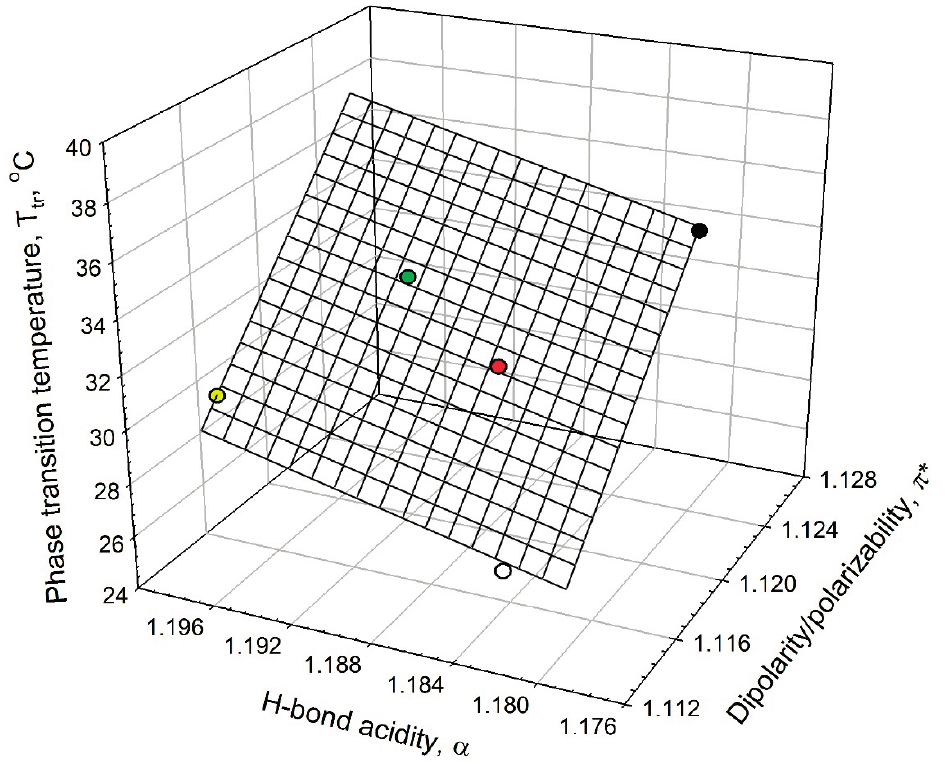
Figure 5. Interrelationship between the phase-transition temperature, T t , in ELP solutions and the solvent dipolarity/polarizability, π *, and H-bond donor acidity, α , in ELP solutions at 0.90 mM concentration in an aqueous 0.01 M sodium phosphate buffer (NaPB) of pH 7.4 (black circle) in the presence of 0.1 M·NaCl (white circle), 0.05 M Na 2 SO 4 (red circle), 0.1 M NaClO 4 (green circle), and 0.1 M·NaSCN (yellow circle) (see Equation